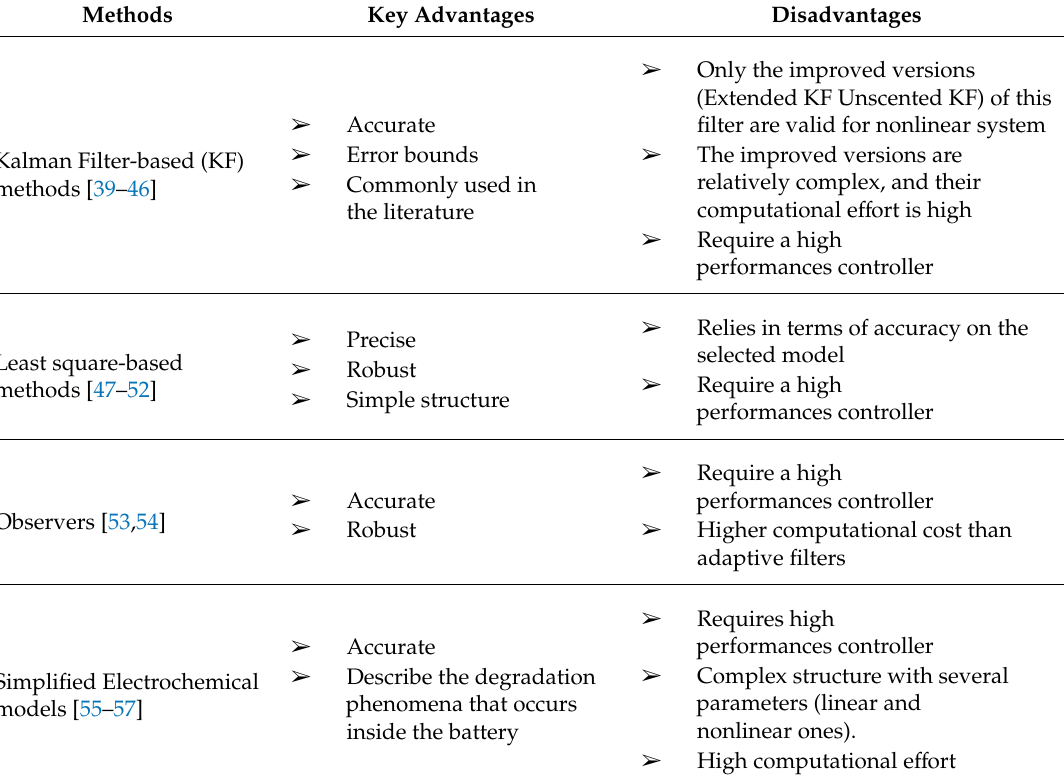
Table 2. Model-based estimation